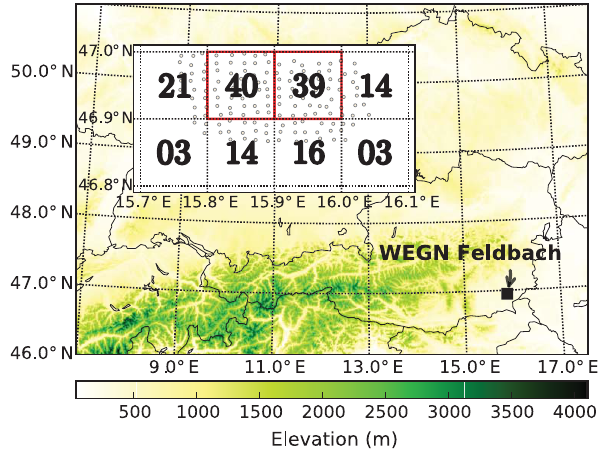
Figure 1. WEGN climate station network in the Feldbach region (black square), southeastern Austria. The inset plot shows an en- larged view of the number of WEGN rain gauges that are located within GPM IMERG 0.1 ◦ × 0.1 ◦ grid cells. The two red-framed grid boxes (within 46.9–47.0 ◦ N, 15.8–16.0 ◦ E), containing 40 and 39 WEGN gauges each, are selected for the study; for brevity, these are also termed “Grid 15.85” and “Grid 15.95” based on mid-